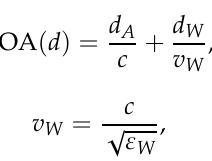
Figure 3. Radar system block diagram.